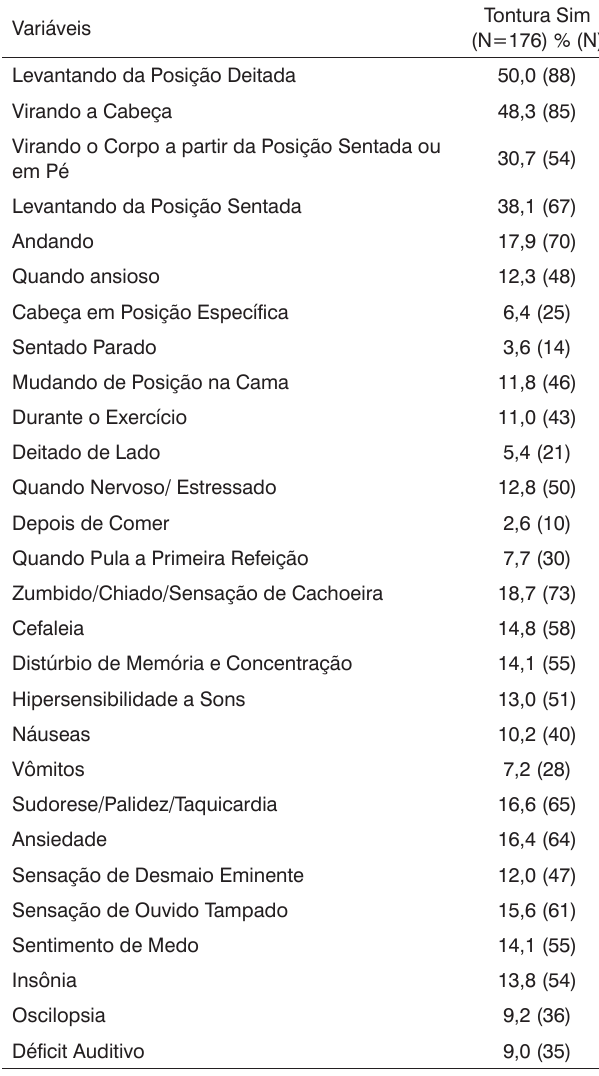
Tabela 1. Caracterização da amostra de idosos com e sem queixa de tontura (N=391) no município de Cuiabá, Mato